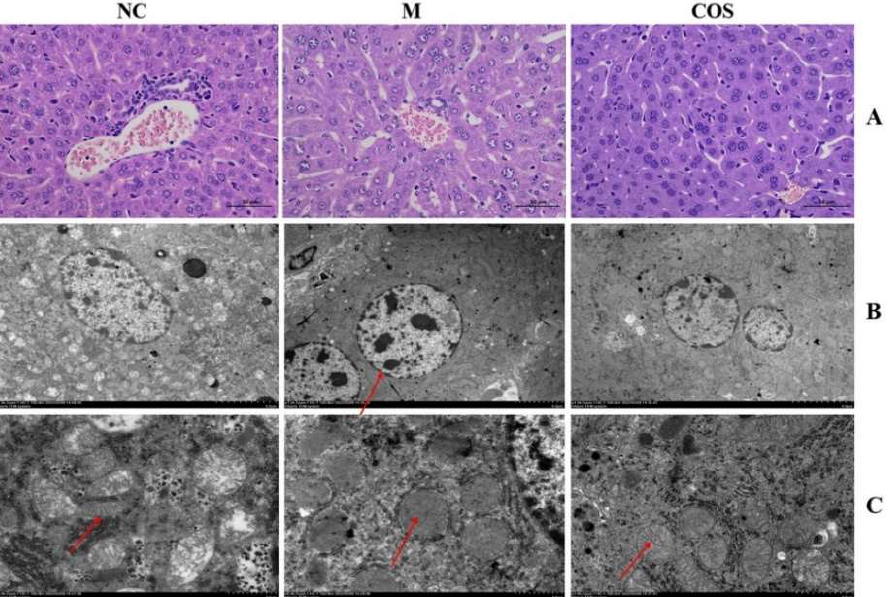
Figure 9. H&E staining and TEM of liver tissue. ( A ) represents the H&E staining of liver tissue; ( B ) represents the nuclei of hepatocytes under the same magnification. The arrow indicates chromatin condensation; ( C ) represents the hepatocyte mitochondria under the same magnification. Arrows indicate mitochondrial inner cristae. Table 1. The mitochondrial scores of mice.